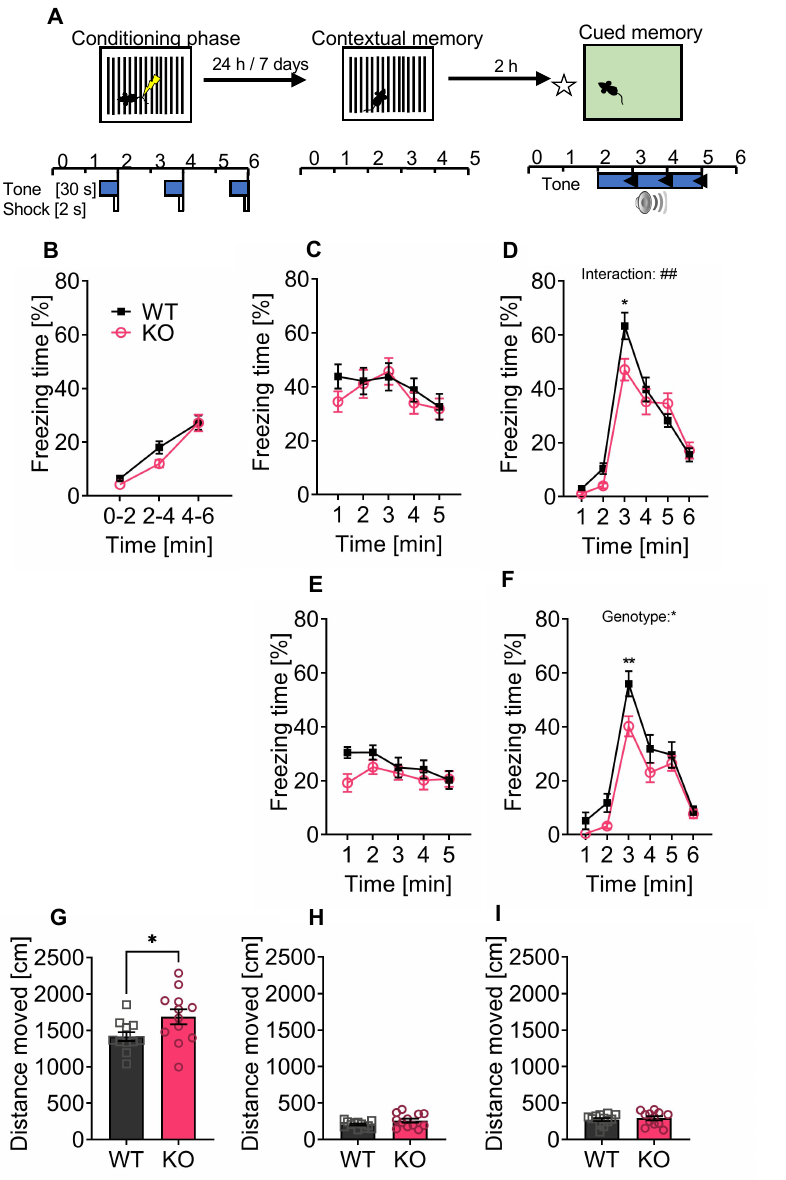
Figure 4. p62 KO mice display normal contextual, cued, and long-term fear memory and showed a reduced freezing after the acoustic stimulus. ( A ) Schematic representation of the fear conditioning protocol. ( B ) During the conditioning phase a foot shock was paired with a tone and repeated three times. Freezing response to the conditioning protocol was similar between p62 KO and WT mice and increased with time and foot shock repetition. ( C ) Contextual memory was tested after 24 h following conditioning. WT and p62 KO mice were introduced to the same arena where they have received foot shocks and showed increased but comparable freezing response. ( D ) Cued memory was tested using a different environment and presentation of the paired tone. The freezing response during the first two minutes before applying the tone was used for the baseline response. p62 KO and WT mice showed intact cued memory with a reduced freezing response in p62 KO animals in the first minute of the tone. ( E ) Contextual memory of mice was tested again after 7 days and confirmed intact contextual memory of WT and p62 KO mice. ( F ) Cued memory tested after 7 days showed intact memory of p62 KO and WT mice with again a reduced response in p62 KO mice when the tone was applied. ( G ) During the conditioning phase p62 KO animals moved a significantly longer distance than the WT mice. No difference in distance moved was identified during ( H ) the context and the ( I ) cued phases. * p < 0.05; ** p < 0.01. Data were analyzed by using 2-way ANOVA repeated measurements ( B – F ) or by using unpaired t -test ( G – I ). All error bars show mean ± SEM. Squares and circles represent single replicates. WT male N = 12; KO male N =